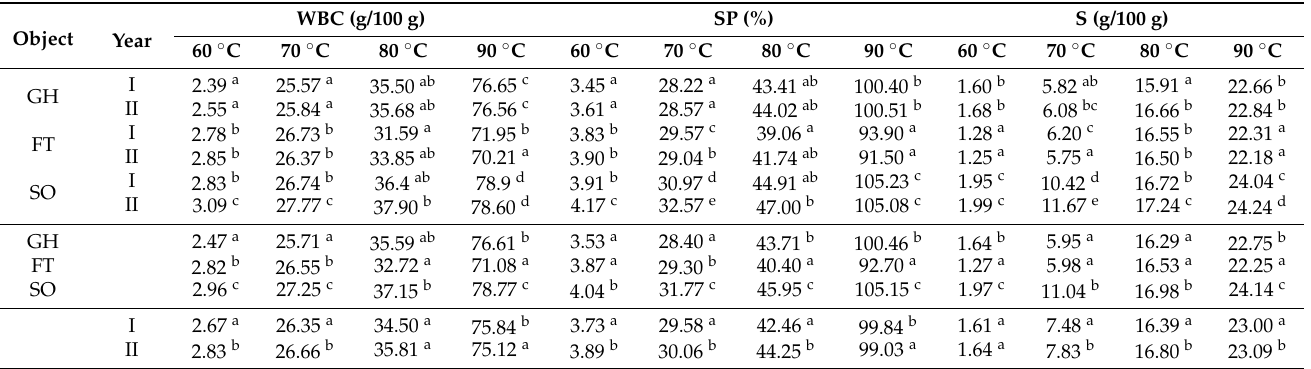
Table 3. Water binding capacity (WBC), swelling power (SP) and starch solubility (S) measured for investigated potato